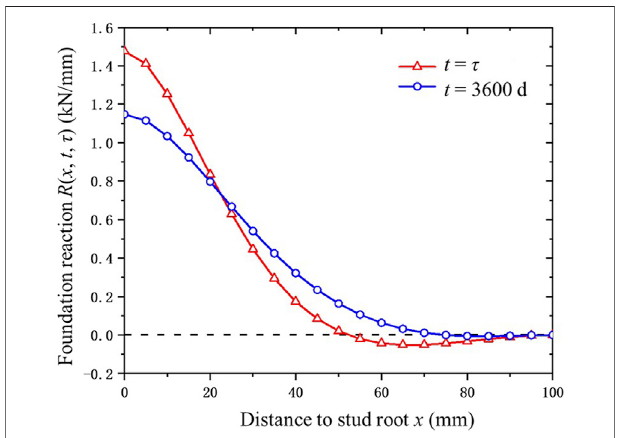
FIGURE 14 | Time-dependent reaction force of the